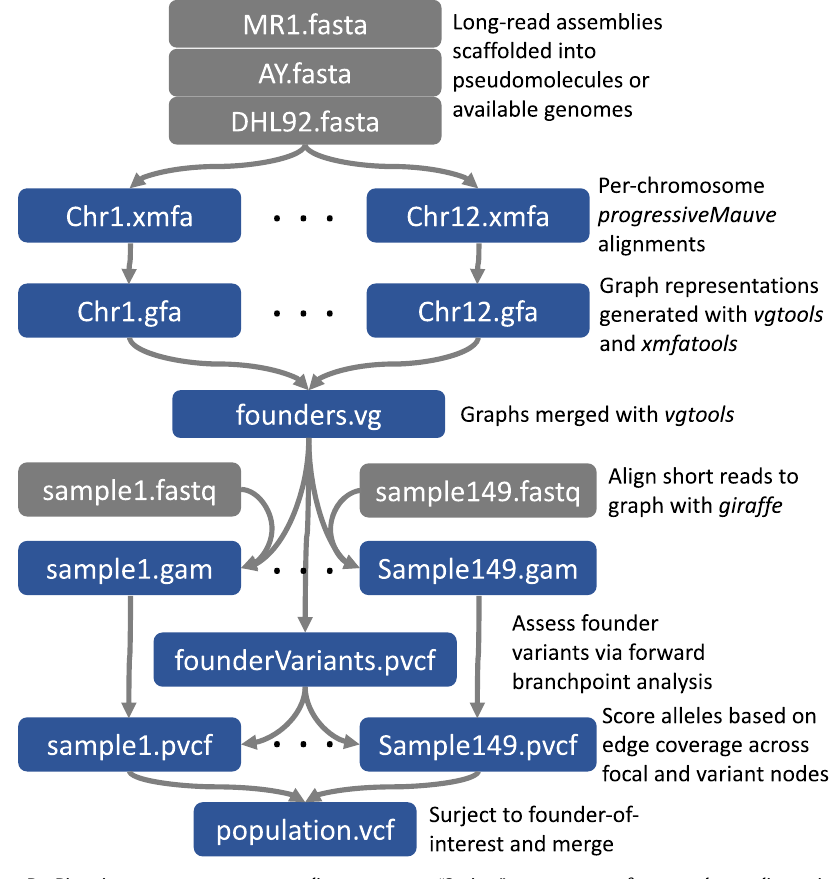
Fig. 2 | PanPipes fl ow diagram. PanPipes incorporates pangenome alignment information during short-read mapping. Files are shown as blocks and each step is annotatedontheright.Grayindicatesthat fi lesoriginatefromoutsidethepipeline.